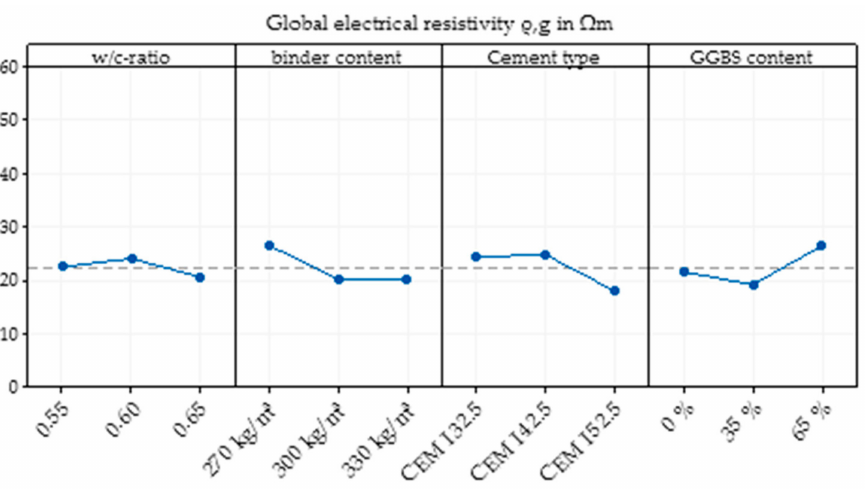
Figure 9. Main effect plot of the concrete composition on the global electrical resistivity of SFRC calculated by Minitab based on the mixtures of the multiple parameter